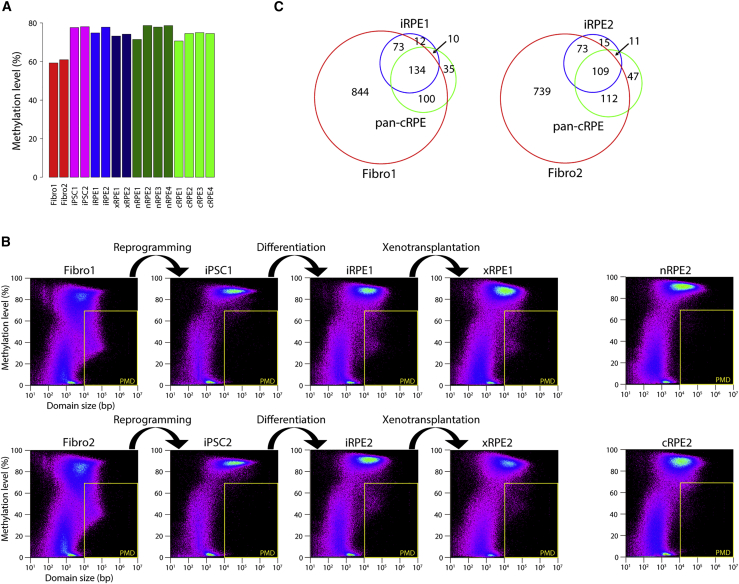
Emergence of PMDs in iRPE(A) Mean mCG levels of the 16 methylomes determined in this study.(B) MDL plots for methylome segmentation. For each domain defined by a change-point detection approach, mean methylation level in percentile (y axis) is plotted against log10 of its size in base pairs (x axis) (Yokoyama et al., 2015). Yellow lines demarcate domains that fulfill the original criteria of PMDs (size >10 kb; mean methylation level <70%) (Lister et al., 2009).(C) Venn diagram for overlap among PMDs in fibroblasts, iRPE, and cRPE. Note that pan-cRPE represents the union of PMDs in cRPE1–4. The number indicates the total size (Mb) of genomic regions in each section of the Venn diagram.